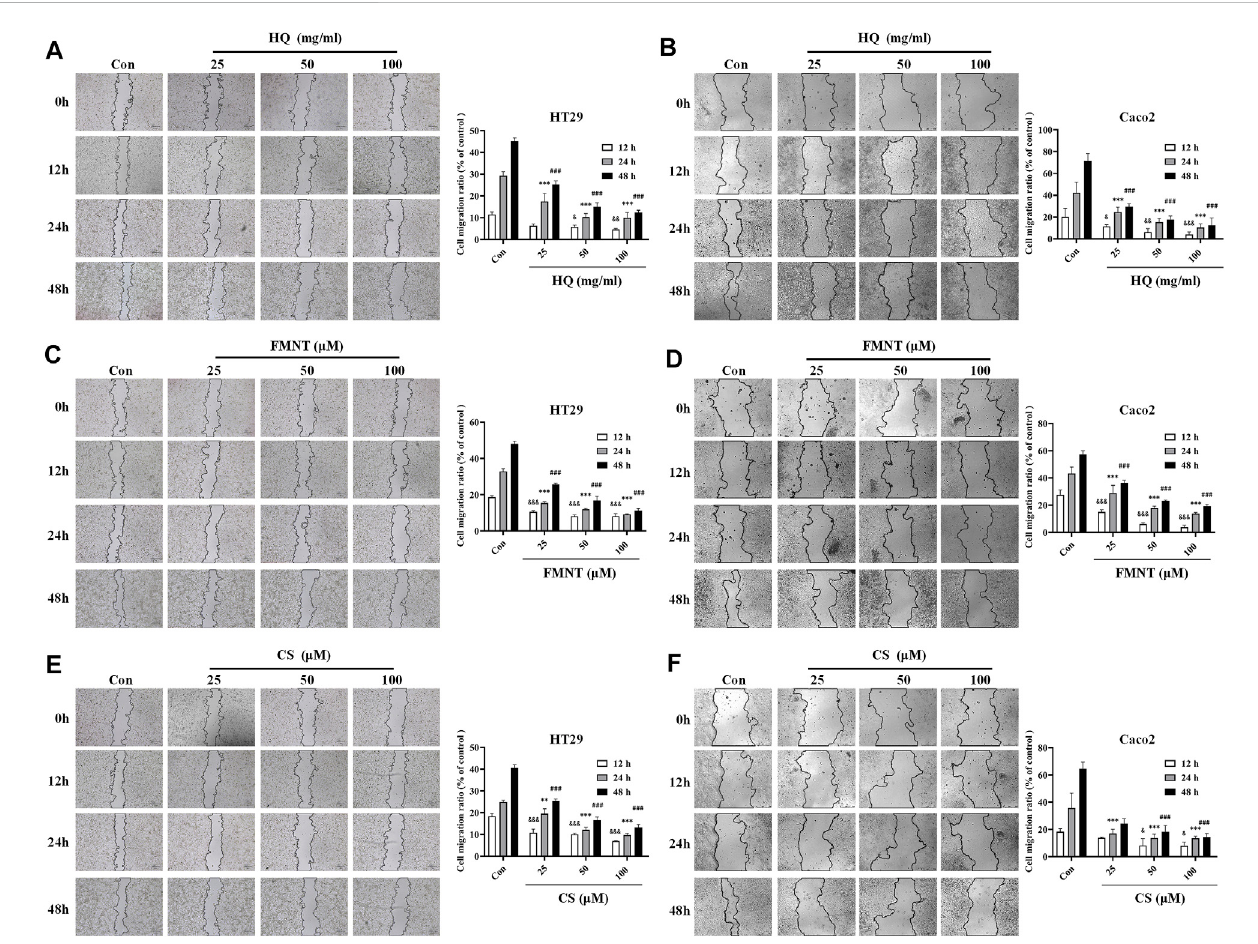
FIGURE 8 HQ,FMNTandCSsigni fi cantlysuppressedthemigrationofHT29andCaco2cells.TheeffectsofHQ(25,50and100 mg/mL) (AandB) ,FMNT(25,50and 100 μ M) (C and D) and CS (25, 50 and 100 μ M) (E and F) on the migration of HT29 and Caco2 cells for 12, 24 and 48 h, respectively. The data represent the mean±SD ( n =3). & p < 0.05, && p < 0.01and &&& p < 0.001comparedwith thecontrolgroupfor 12 hincubation.*** p < 0.001 compared withthecontrol group for 24 h incubation. # p < 0.05, ## p < 0.01 and ### p < 0.001 compared with the control group for 48 h